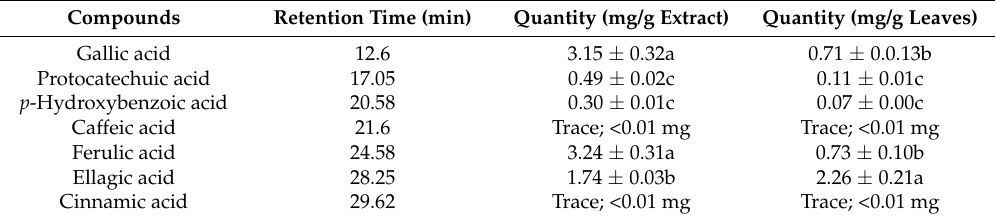
Table 7. Phenolic compound contents (mg/g) of the ethyl acetate extract of C. crenata leaf identified and quantified by GC-MS and HPLC,